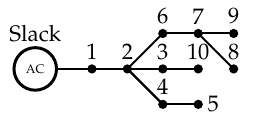
Figure 2. Electrical configuration of the 10-node radial test system.